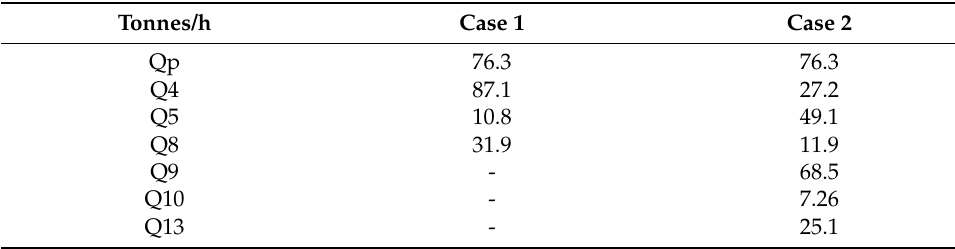
Table 3. MATLAB simulation results of mass flow Q for Case 1 and Case